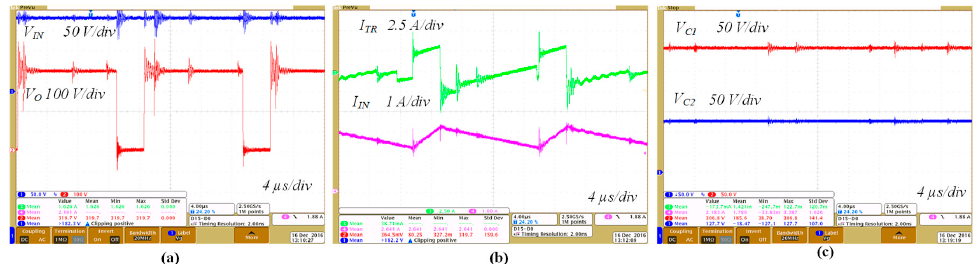
Figure 20. Experimental results of the A-source inverter: ( a ) Input voltage ( V in ) along with the dc-link voltage ( V o ), ( b ) input current ( I in ) along with the inductor current ( I L 2 ), and ( c ) voltage across capacitors V C 1 and V C 2 .